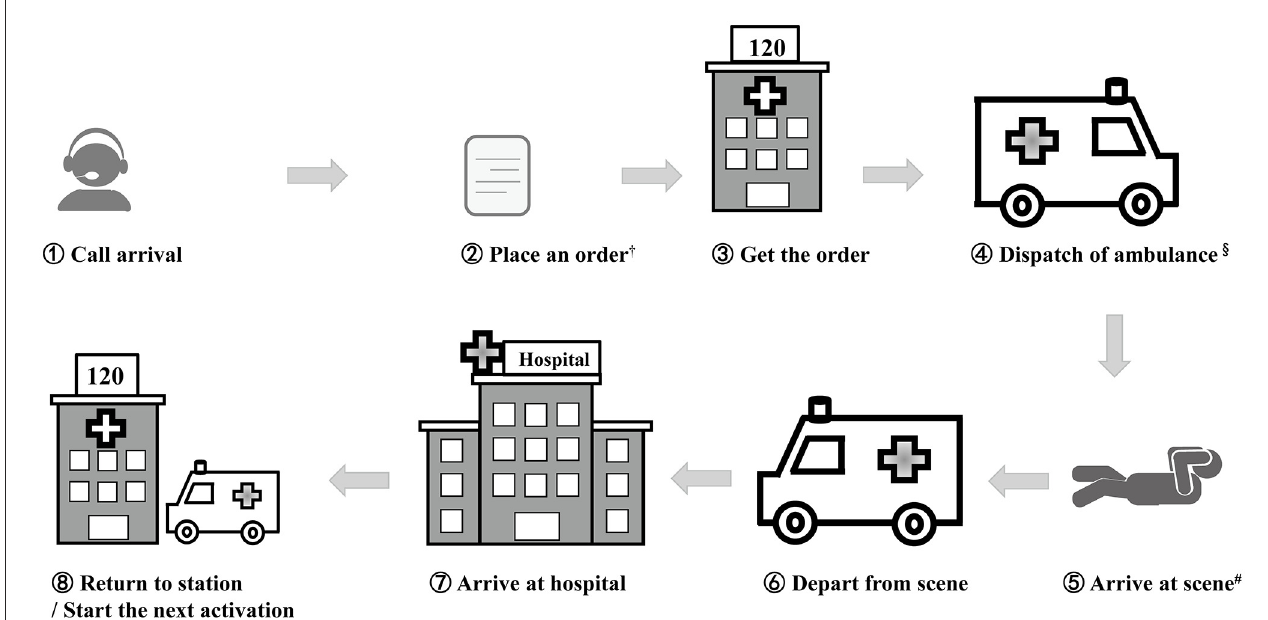
FIGURE3 Process of EMS utilization in Tianjin. † Step 1 and Step 2 were implemented simultaneously in 2021. § The ambulances were directly dispatched by the municipal emergency medical center in urban and sub-urban areas; the rural implemented regional ambulances dispatched by the emergency medical subcenter. # Some EMS utilization was transportation from one hospital. Response time